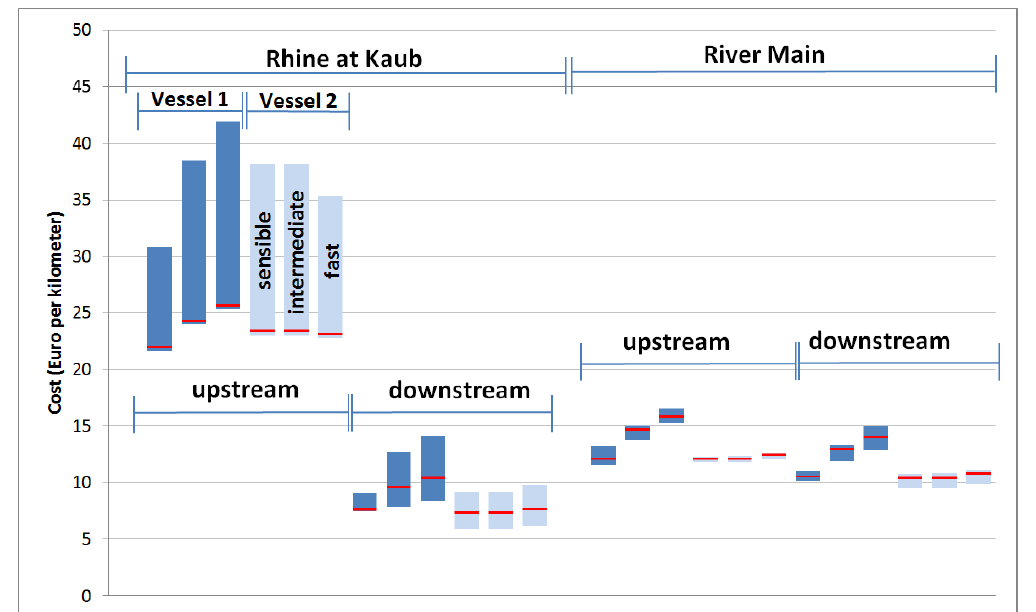
Figure 12. Bandwidth of cost per fairway section for ship 1 - 'sensible sailing' To further assess the effect of sailing regime and engine power on the transportation cost at a given waterway section, Figure 13 zooms in on the waterway near Kaub (i.e. the section where upstream transportation cost reaches 32 euro per kilometre due to high current velocity) and on the ‘Main’ (i.e. the long section where upstream and downstream costs are close together due to moderate current velocities). The figure shows the costs of both ships. From left to right, the columns per ship represent sensible, intermediate and fast sailing. The lower and upper bound of each column represent the minimum and maximum costs over the entire range of water levels. The costs at average water level are indicated by the red line.